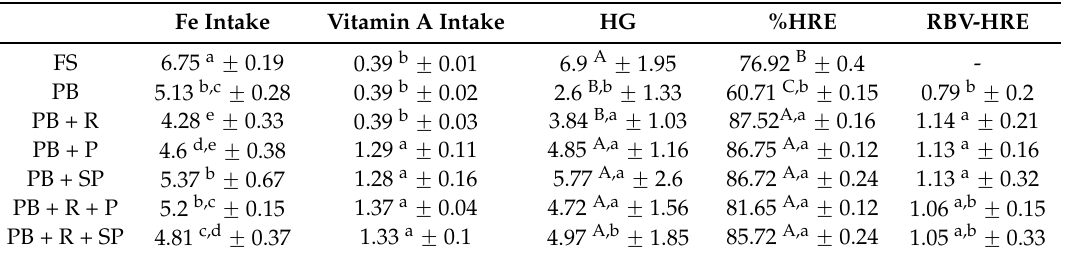
Table 4. Total intake of iron and vitamin A and indices for assessing iron bioavailability ( n =